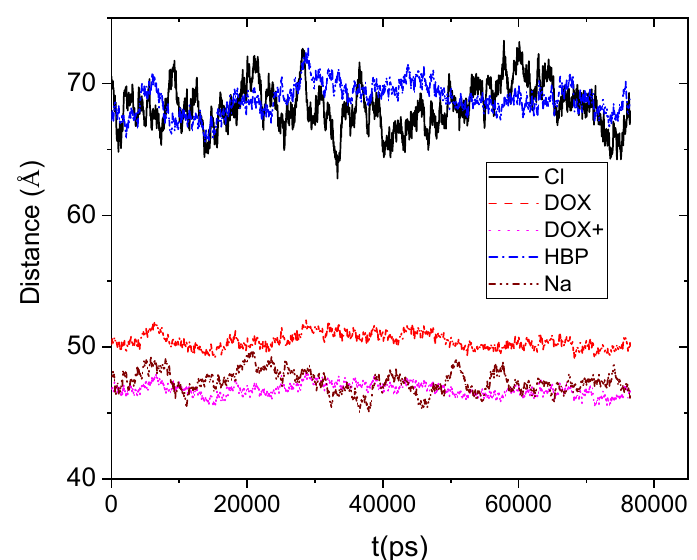
Figure 4. Average distance as a function of time between the center of mass of the lipid membrane (considered as an individual molecule including all the lipids) and those of the hyperbranched polymer, the counterions (Cl − , Na + ), and the neutral (DOX) and the protonated (DOX+) drug molecules.